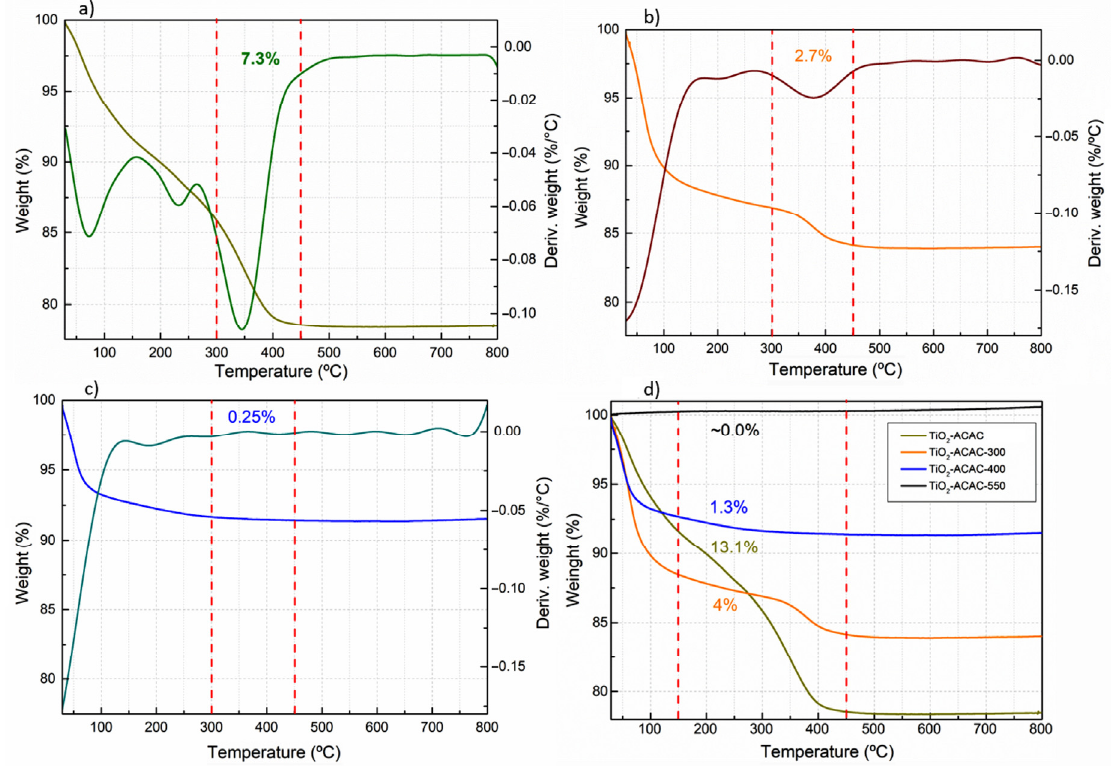
Figure 2. TGA and DTG curves of ( a ) TiO 2 -ACAC; ( b ) TiO 2 -ACAC-300; ( c ) TiO 2 -ACAC-400; ( d ) TGA curves of all TiO 2 -based samples. In ( a – c ), vertical dashed lines mark mass loss due to ACAC bounded to TiO 2 . In ( d ), vertical dashed lines mark the temperature range related to the overall mass loss of ACAC (adsorbed and bounded).